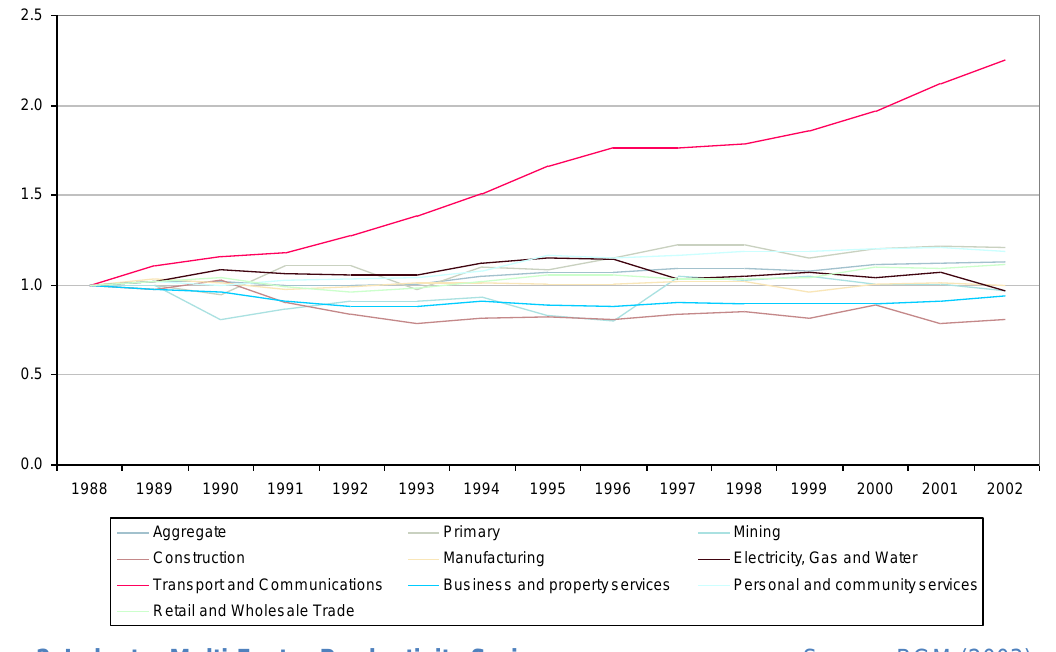
Figure 2 Industry Multi-Factor Productivity